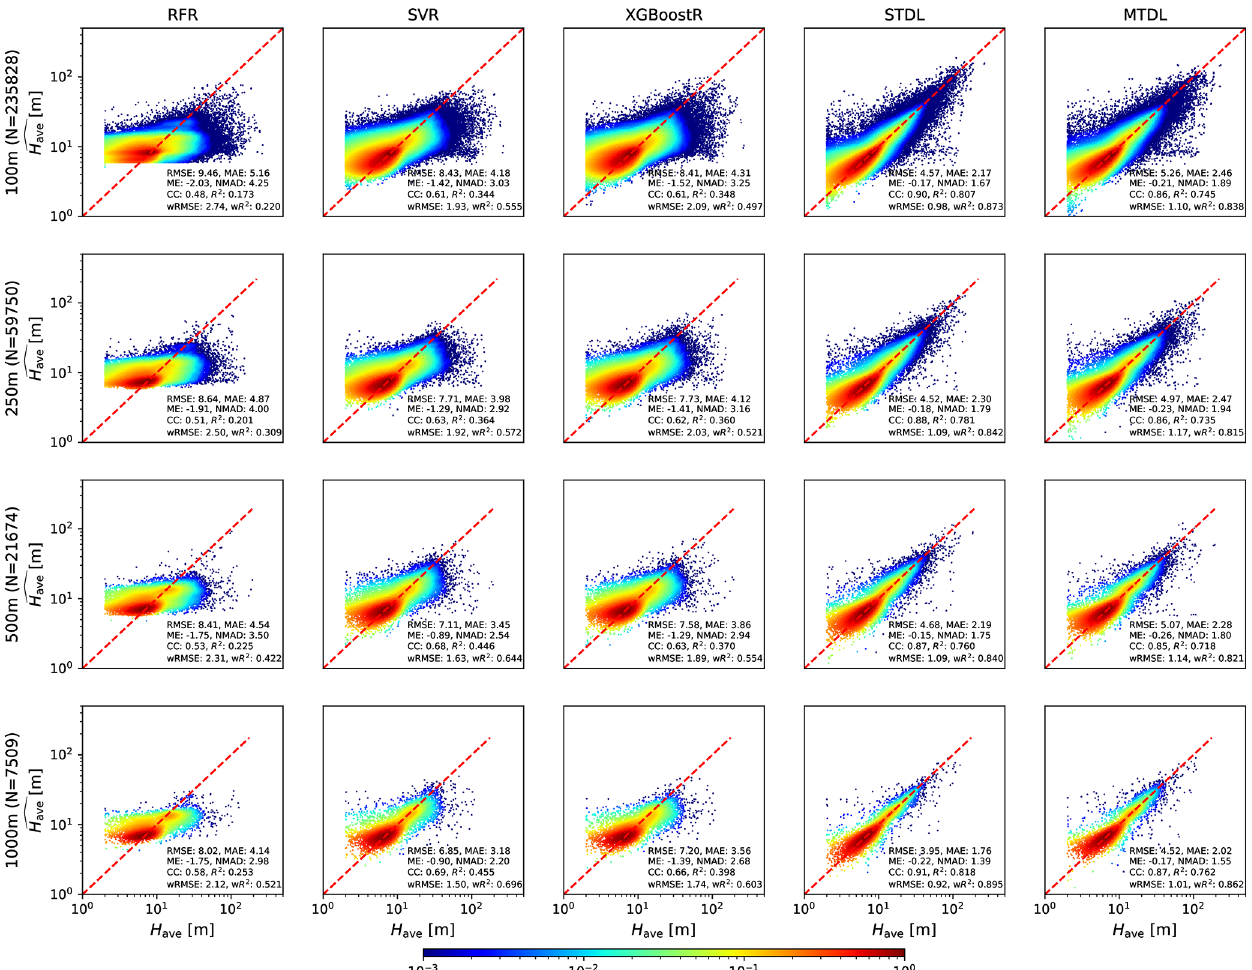
Figure 4. H ave predicted by ML models and DL models. The density of scatter points is normalized to [10 − 3 , 1] and represented using shading colours. The presented evaluation metrics are calculated based on the reference values from D test , 2 which consists of samples from 43 cities by patch-level sampling (See Sect. 2.2.3 for